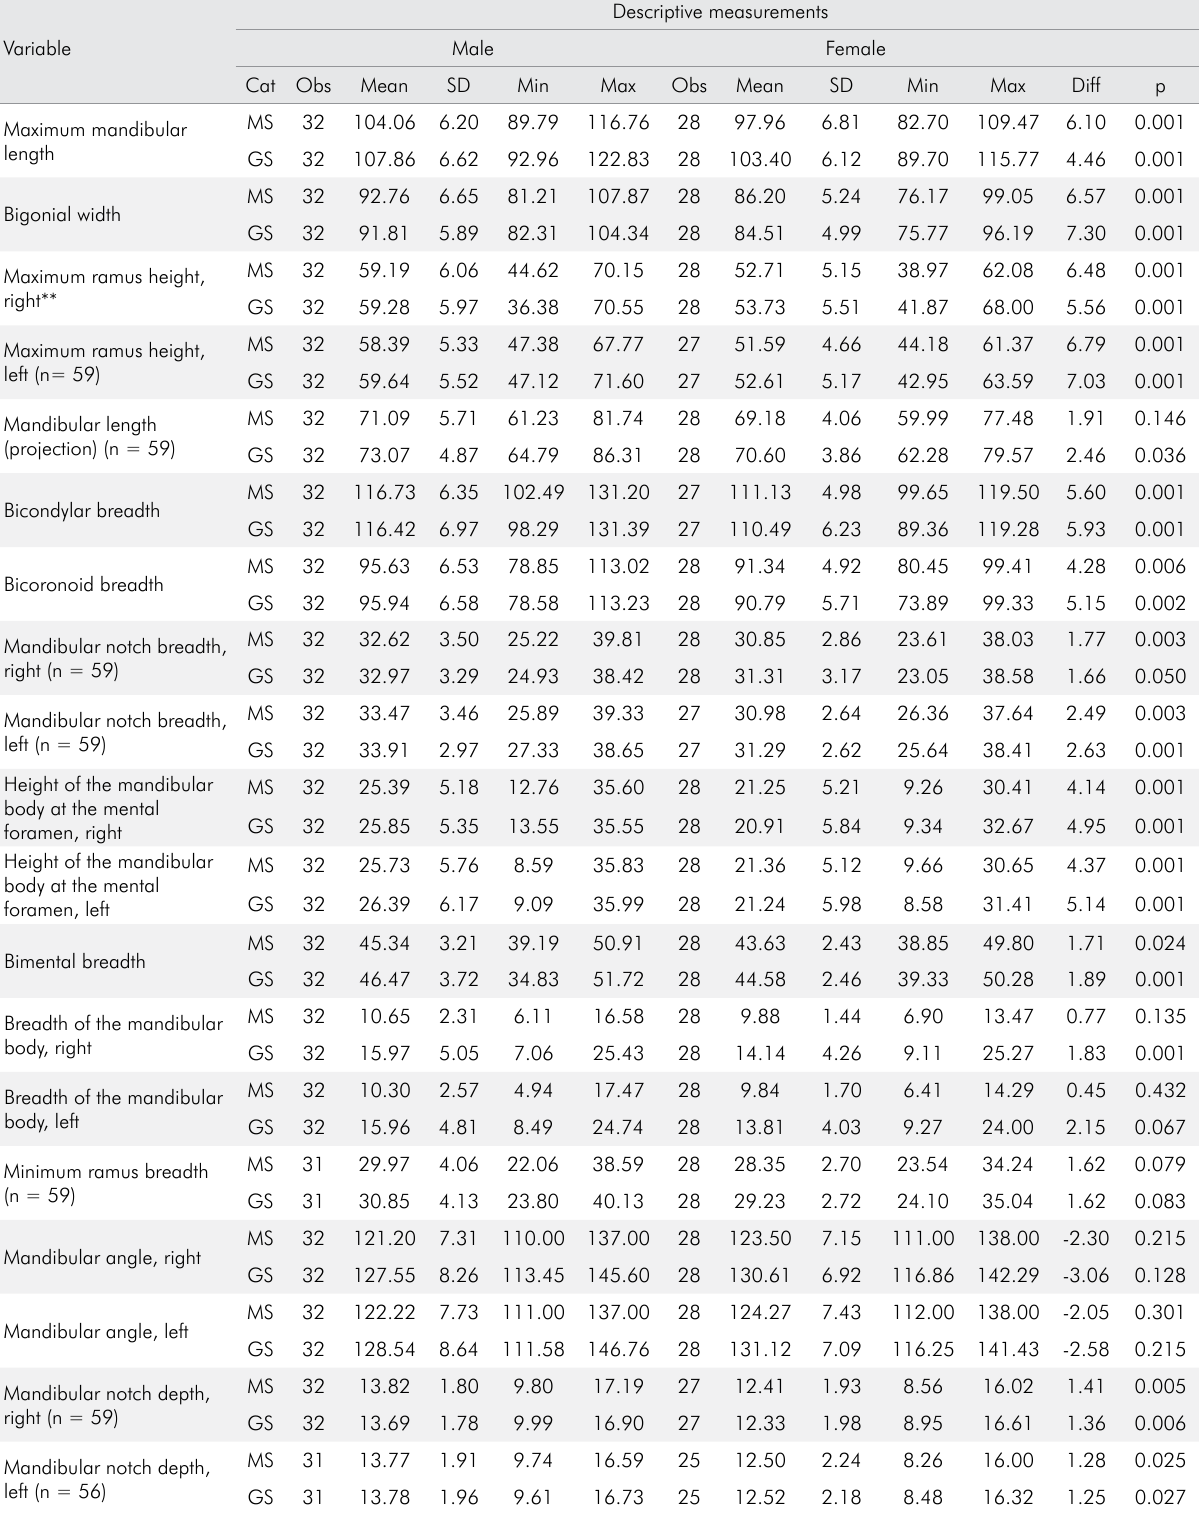
Table 4. Descriptive statistics of the measurements using the mandible statibilizer (MS) and the tomographic measurements (GS, golden standard) for each